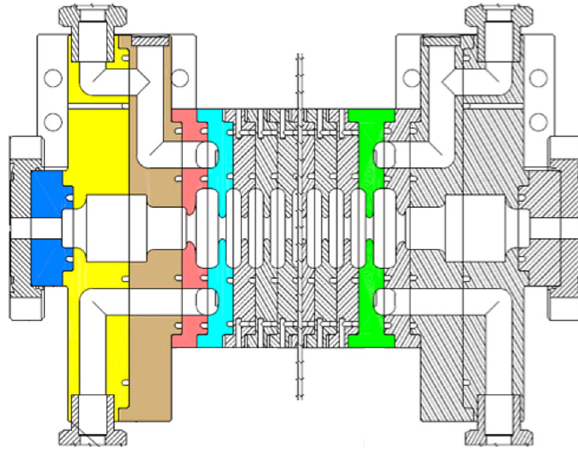
FIG. 17. Coupler (blue, yellow, and brown), special disk (red, cyan, and green) and regular disk